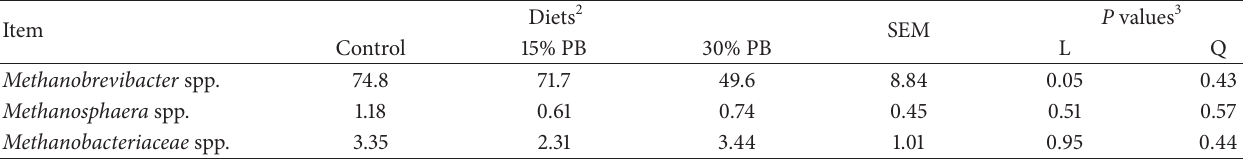
Table 4: Quantification of hindgut methanogenic archaea diversity present in meat goat ( n = 6) as analyzed using bTEFAP pyrosequencing method 1